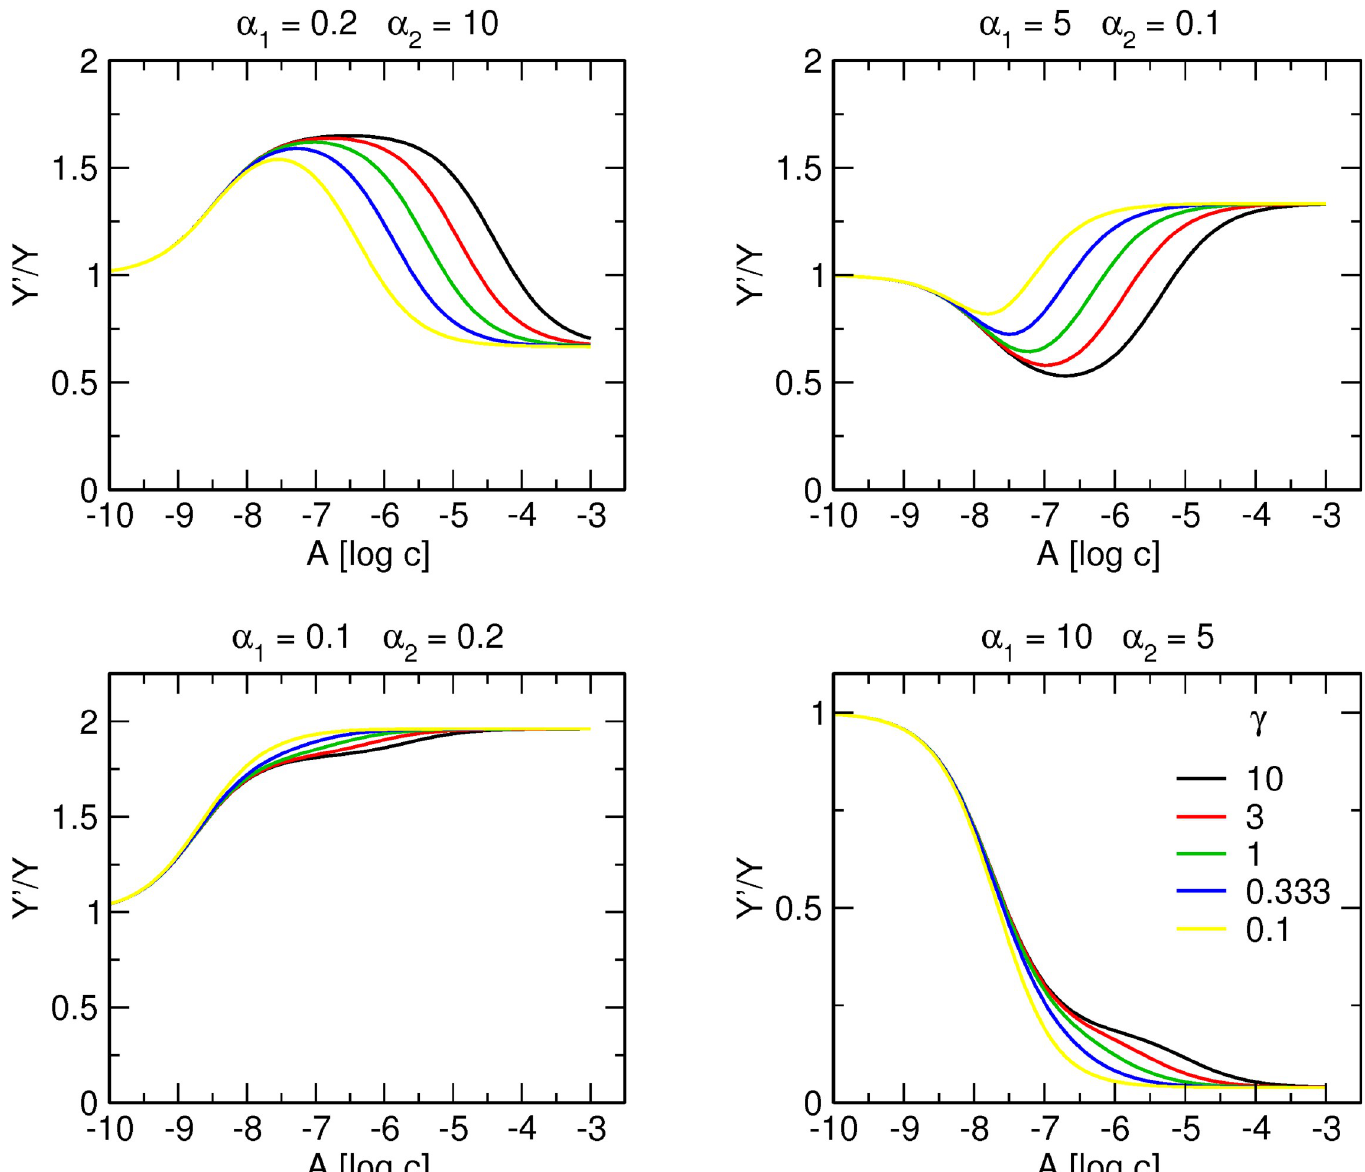
Fig 10. Effect of γ value on binding of allosteric modulator to two allosteric sites. Simulation of tracer binding (ordinate) in the presence an allosteric modulator binding to two allosteric sites for various combinations of positive and negative cooperativity with the tracer indicated at headings of individual plots. Binding of the tracer is expressed as fold over control binding in the absence of allosteric modulator. Abscissa, concentration of allosteric modulator expressed as logarithm of molar concentration. Value of cooperativity factor γ is shown in the graph legend. Simulation parameters: K X = 0.1 nM, [X] = 0.1 nM K A1 = 100 nM, K A2 = 1 μ M, δ = 1.